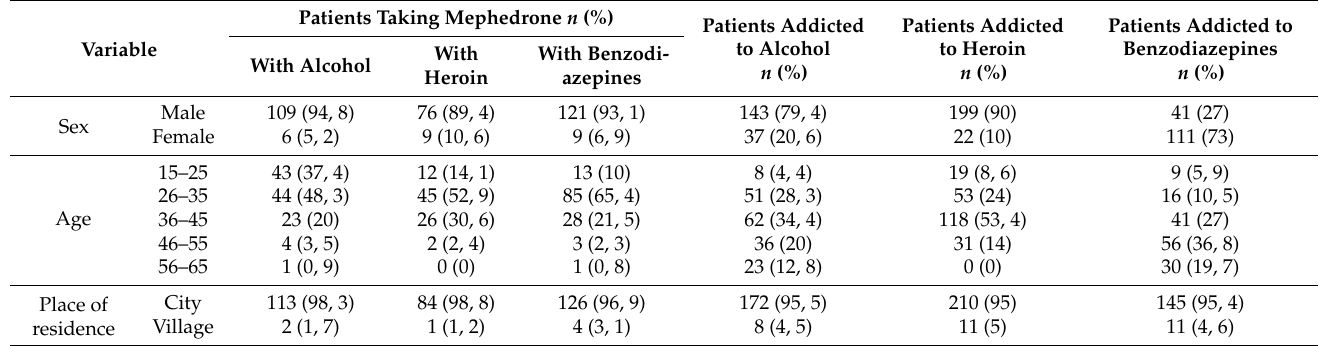
Table 1. Sociodemographic data of the compared groups.